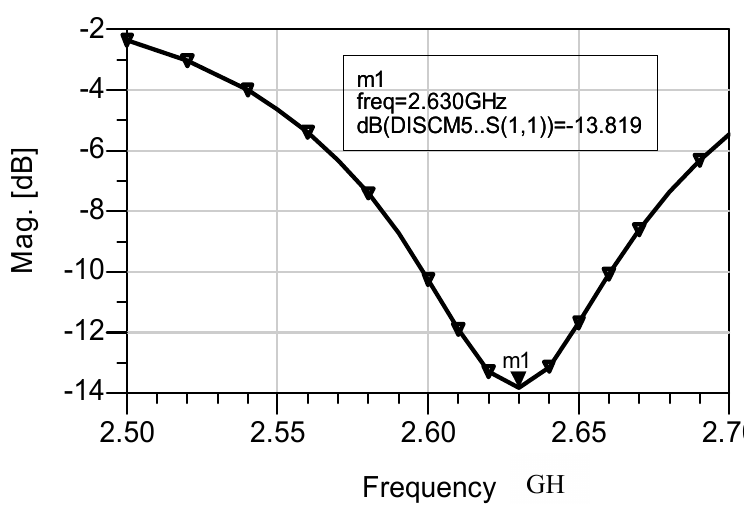
Figure 3. S11 of the wearable circular microstrip antenna with CSRR.